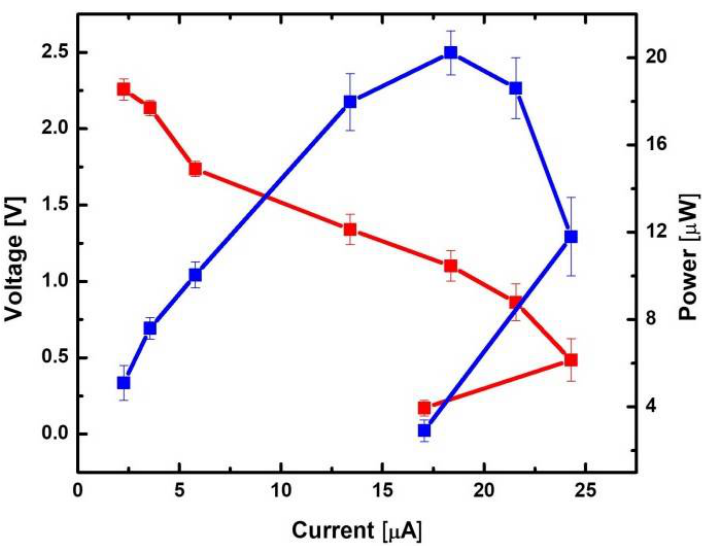
Figure 8. Polarization curves and output powers measured from the nine-MFC stack with wastewater activation liquid.